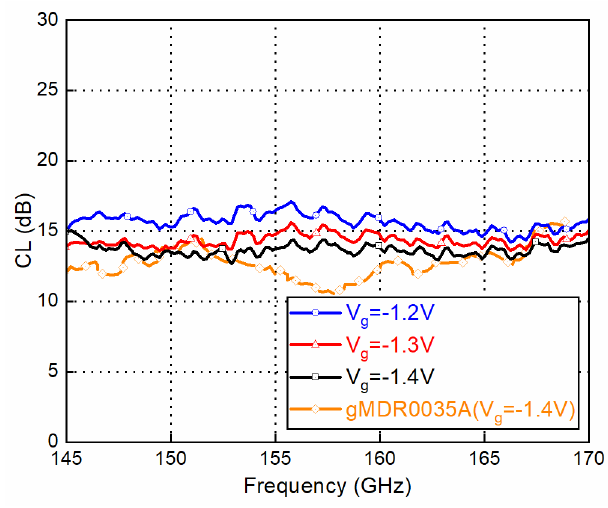
Figure 18. Conversion loss (CL) vs. frequency. (RF @ − 20 dBm and LO @ 13 dBm). Three modules were fabricated and measured. The conversion loss with the down- conversion mode is shown in Figure 19. There is almost no frequency shifting between the different modules, and the performance discrepancies are acceptable.